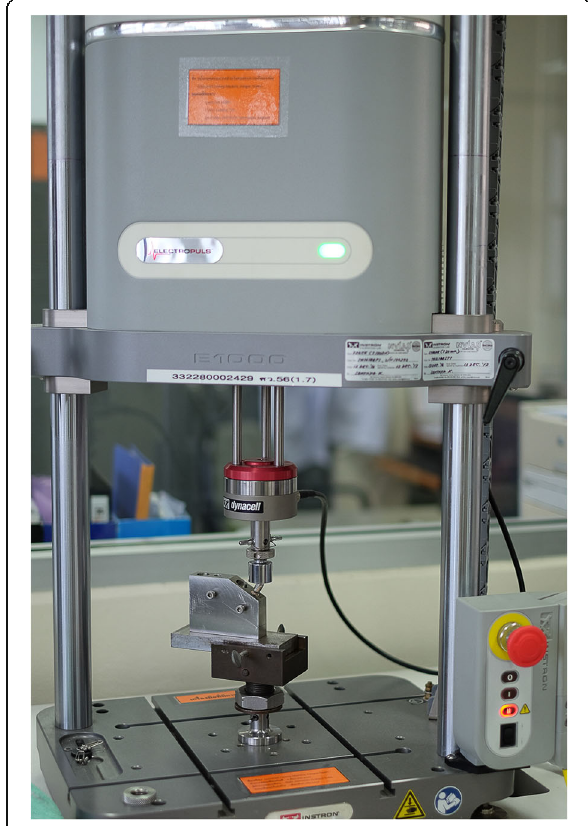
Fig. 5 Specimen mounted in a 30°-angled steel holder in ElectroPuls E1000 dynamic testing machine